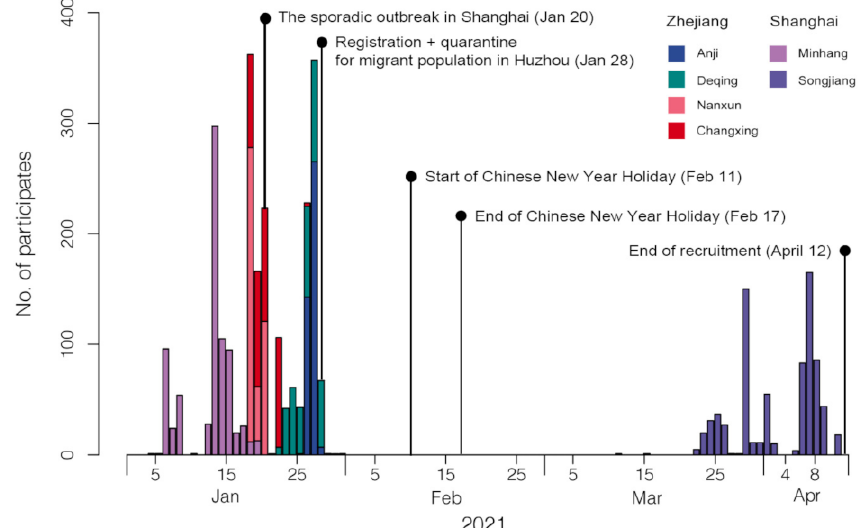
Figure 1. Timeline of the survey. The recruitment date from 4 January 2021 to 12 April 2021. The investigation was suspended for a period of time because of the sporadic outbreak in Shanghai, the Chinese New Year holidays, and the implementation of quarantine policies during the Spring Festival travel